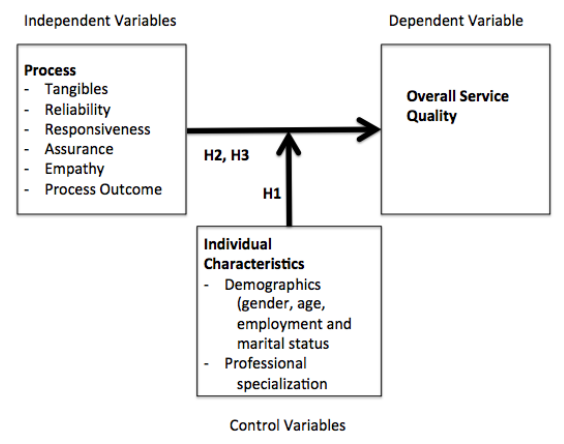
Figure 1: Theoretical model Methodology